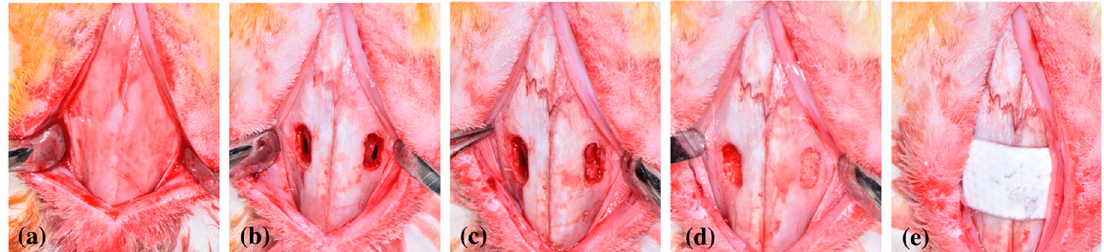
Figure 1. Clinical photographs of the surgery ( a ) after flap elevation, ( b ) during preparation of the bony access windows and perforation of the Schneiderian membrane, ( c ) during placement of a collagen barrier in one sinus, ( d ) during insertion of collagenated synthetic bone substitute material, and ( e ) during closure of the bony window with a cross-linked collagen membrane.